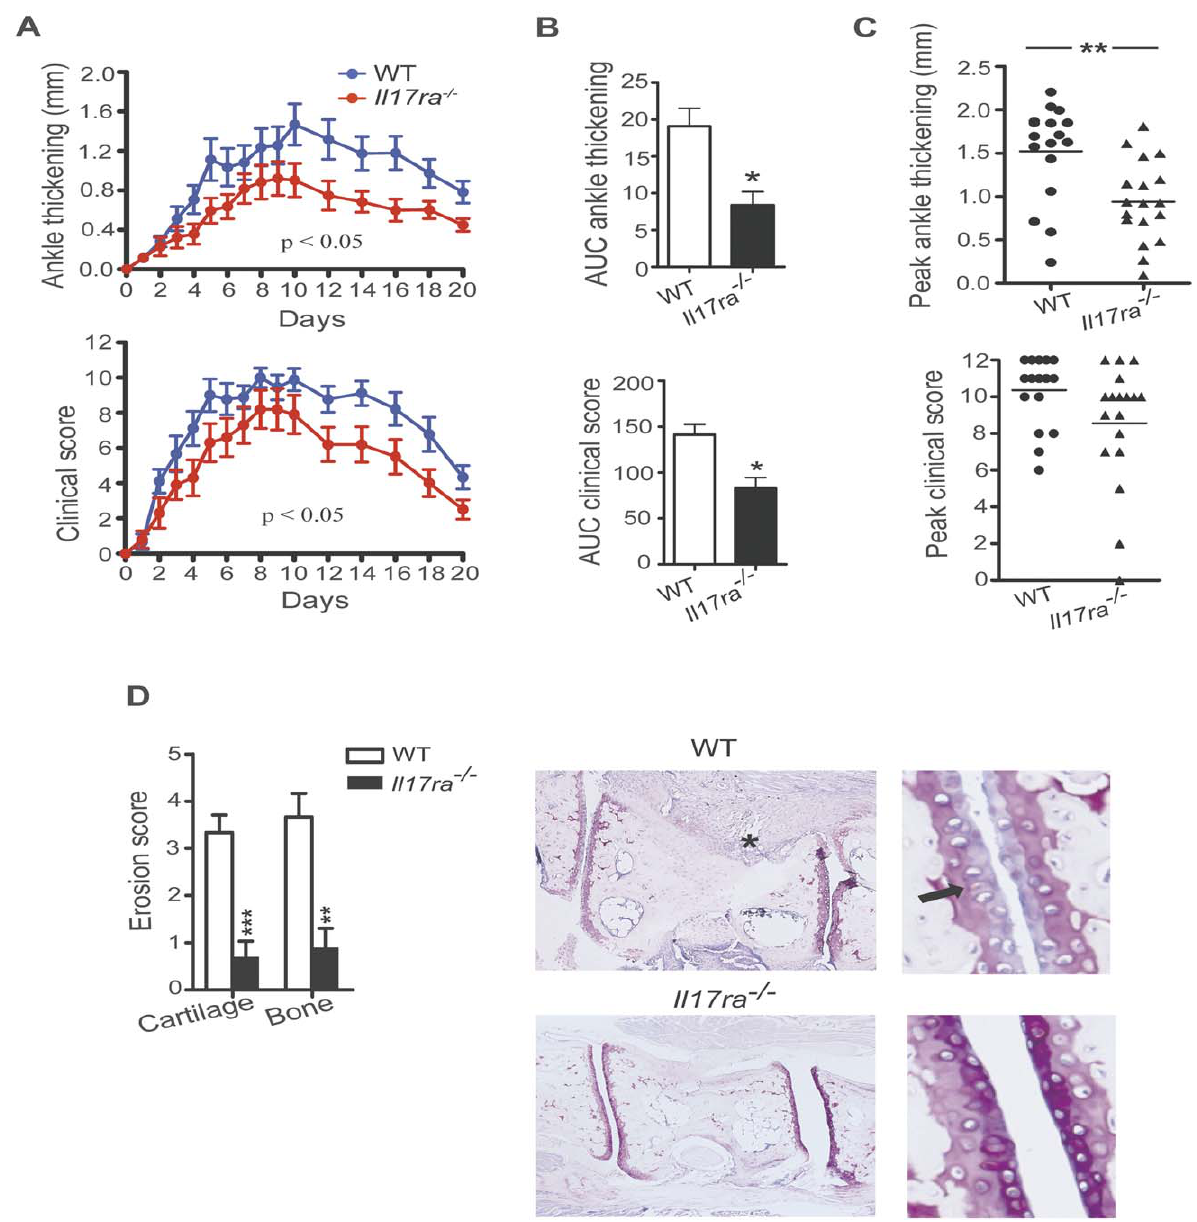
Figure 1. IL-17RA deficiency attenuates severity of K/BxN serum induced arthritis. A, WT (n=9) and Il17ra 2 / 2 mice (n=10) were injected with K/BxN serum and were monitored for 20 days recording daily ankle thickness and clinical score. Data are presented as mean 6 SEM. The AUC for the ankle thickness and for the clinical score of every individual mouse was calculated and statistical differences between wild-type and Il17ra 2 / 2 mice were determined by unpaired two-tailed Student’s t test. One representative of three independent experiments is shown. The number of mice stated above refers to this one representative experiment. B, AUCs for the ankle thickness and the clinical score of WT (n=17) and Il17ra 2 / 2 mice (n=18) were calculated. Each column represents mean 6 SEM. Data were pooled from three independent experiments, and statistical differences were determined by unpaired two-tailed Student’s t test. C, Peak ankle thickness and the peak clinical score reached by each WT ( N ) (n=17) and Il17ra 2 / 2 ( m ) mice (n=18) are shown. Each dot or triangle represents one individual mouse. Data were pooled from three independently performed experiments. D, Histopathological score of cartilage and bone erosions in WT (n=9) and Il17ra 2 / 2 mice (n=10) are presented as mean 6 SEM from ankles harvested on day 21. Data shown are from one representative out of three independently performed experiments. Histopathological score was assessed in toluidine-blue stained specimens. Representative histologies for the wild-type and Il17ra 2 / 2 groups are shown. The asterisk marks a site of pannus infiltration into the bone already visible under low magnification. The arrow indicates a site of proteoglycan loss of the cartilage. Both findings were typical for the wild-type group but not for the Il17ra 2 / 2 group. In ( C ) and ( D ) statistical analyses were conducted using Mann-Whitney- Wilcoxon test. *=p , 0.05; **=p , 0.01; ***=p , 0.001. doi:10.1371/journal.pone.0026342.g001 between those two amplifiers of arthritis. Expression of IL-17A has detected in inflamed joints after injection of K/BxN serum. Those also been linked to bone and cartilage erosions through the levels tended to be decreased in the joints of Il17ra 2 / 2 mice compared to wild-type mice (Table 1), suggesting a possible link induction of RANKL, which is induced in inflamed joints